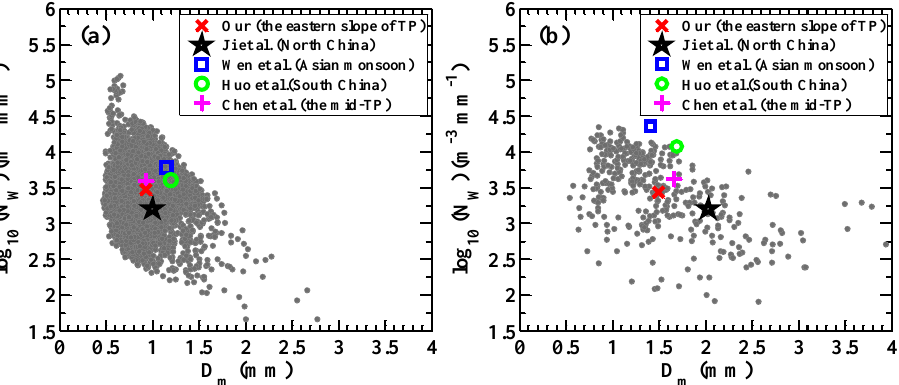
but smaller than those of other areas. North China,